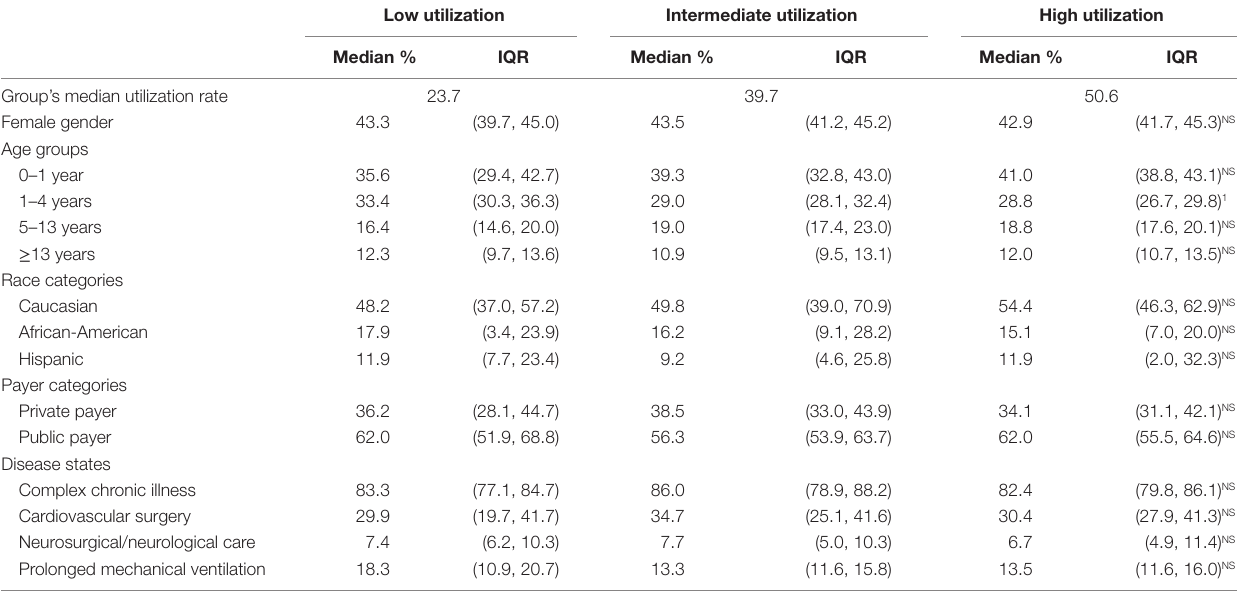
TaBle 1 | Patient characteristics among intermediate, high, and low utilization hospitals, 2012–2013. low utilization intermediate utilization high